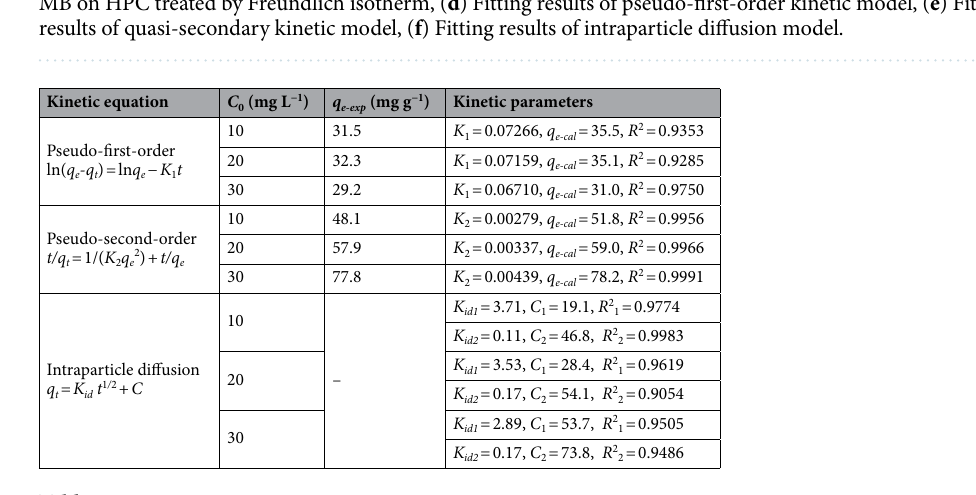
Table 2. Kinetic parameters at various MB